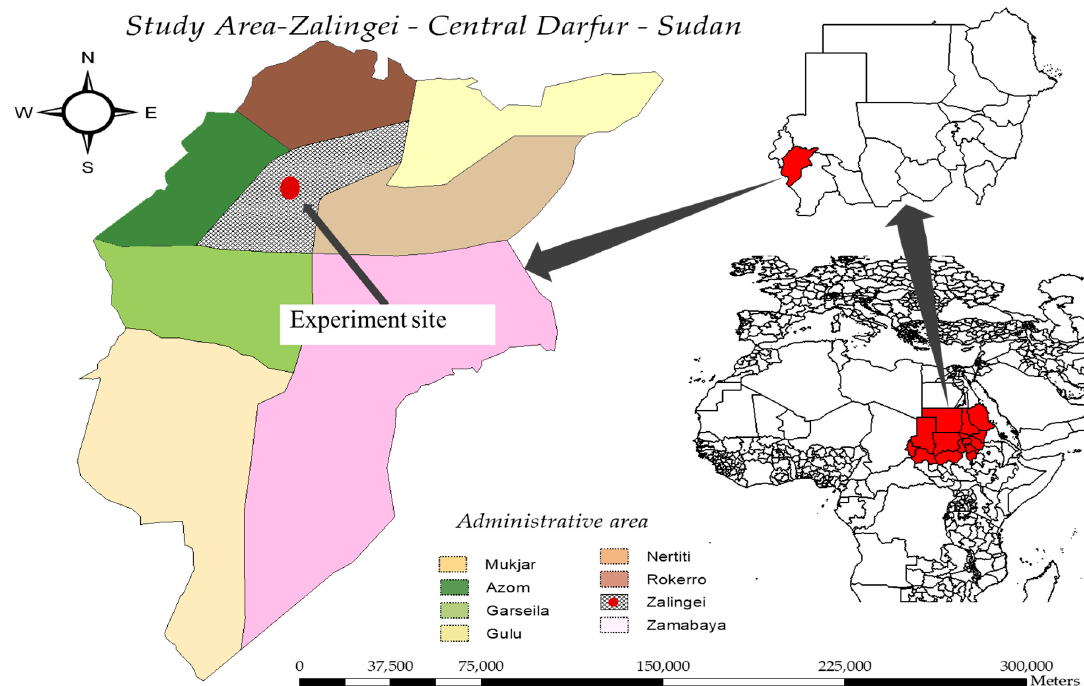
Figure 1. The study area, located in the semiarid zone of North Africa.